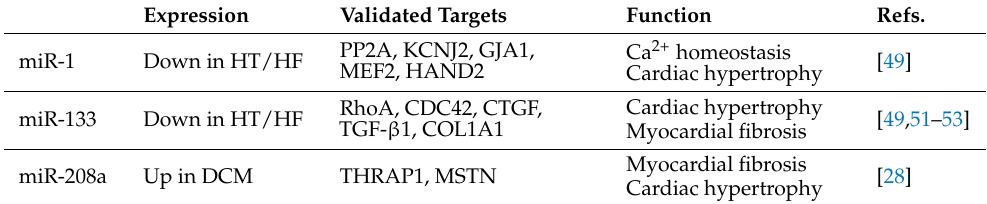
Table 3. Cardiopathological relevance of muscle-specific DMD-related miRNAs.